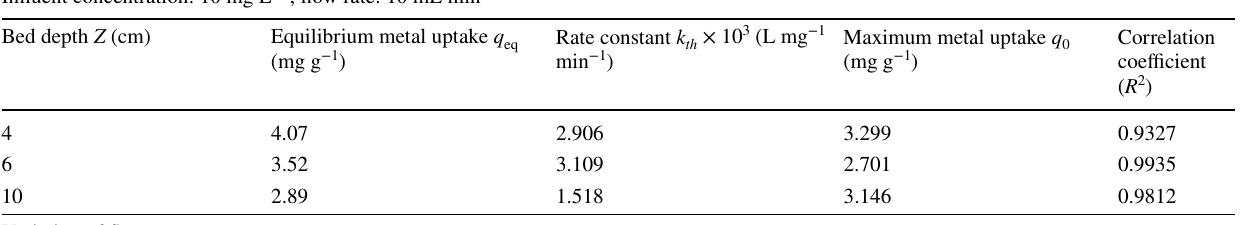
Table 2 Model parameter for Thomas